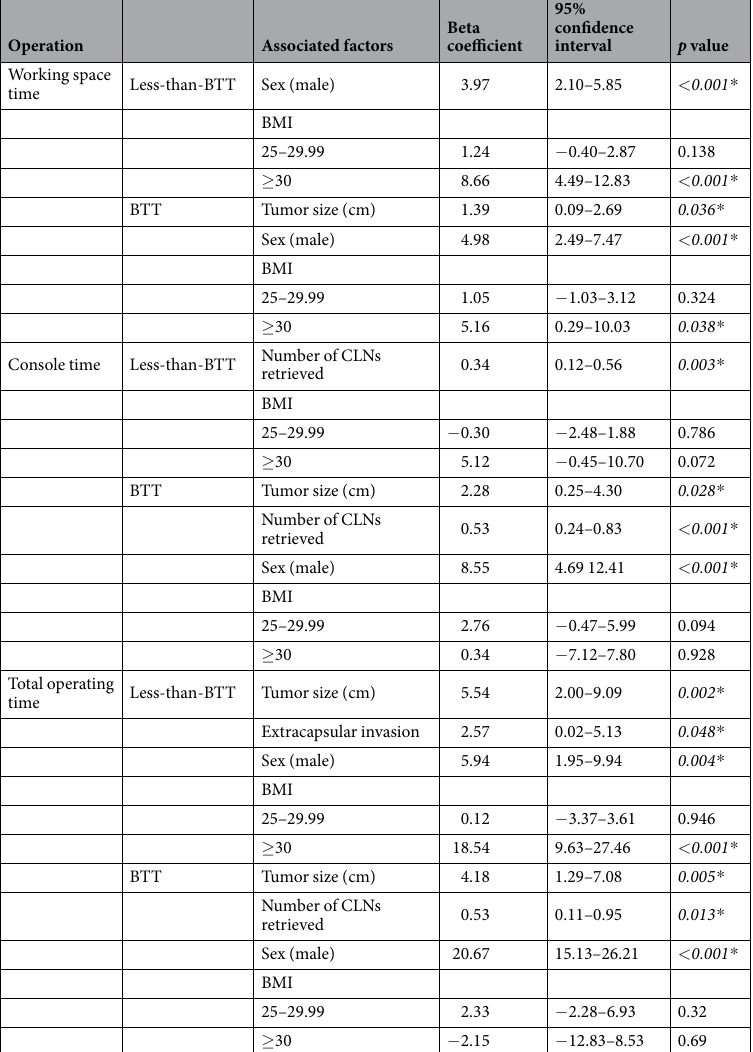
Table 5. Factors associated with operating time in multivariate analysis All times in minutes; BMI, body mass index, in kg/m 2 ; BTT, bilateral total thyroidectomy; CLN, central lymph node; * statistically significant at p <